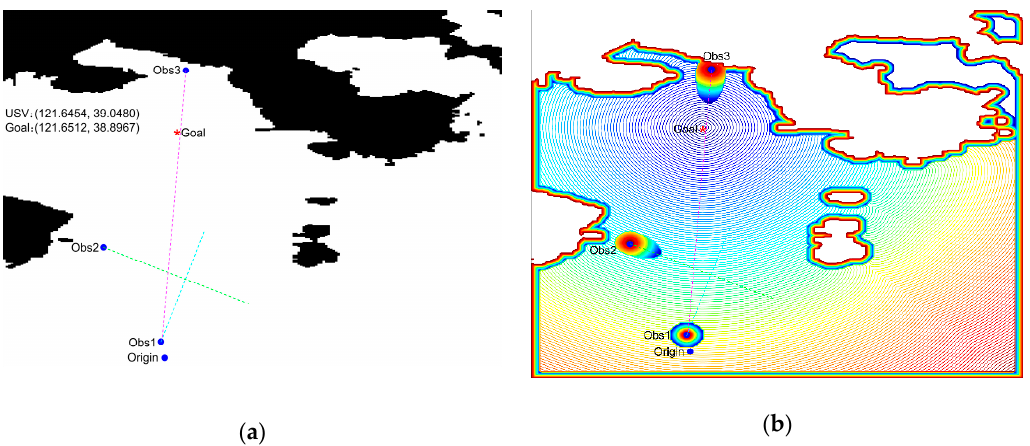
Figure 25. Initial situation of local dynamic planning: ( a ) original map; ( b ) potential field diagram.